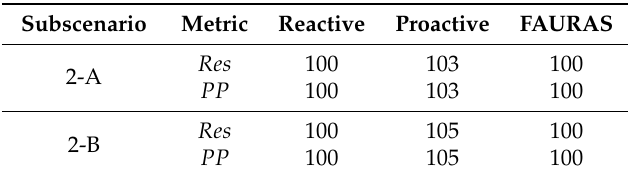
Table 9. Number of HTTP responses and PUSH_PROMISE frames of the client a 1 when using proxy-based methods in scenario